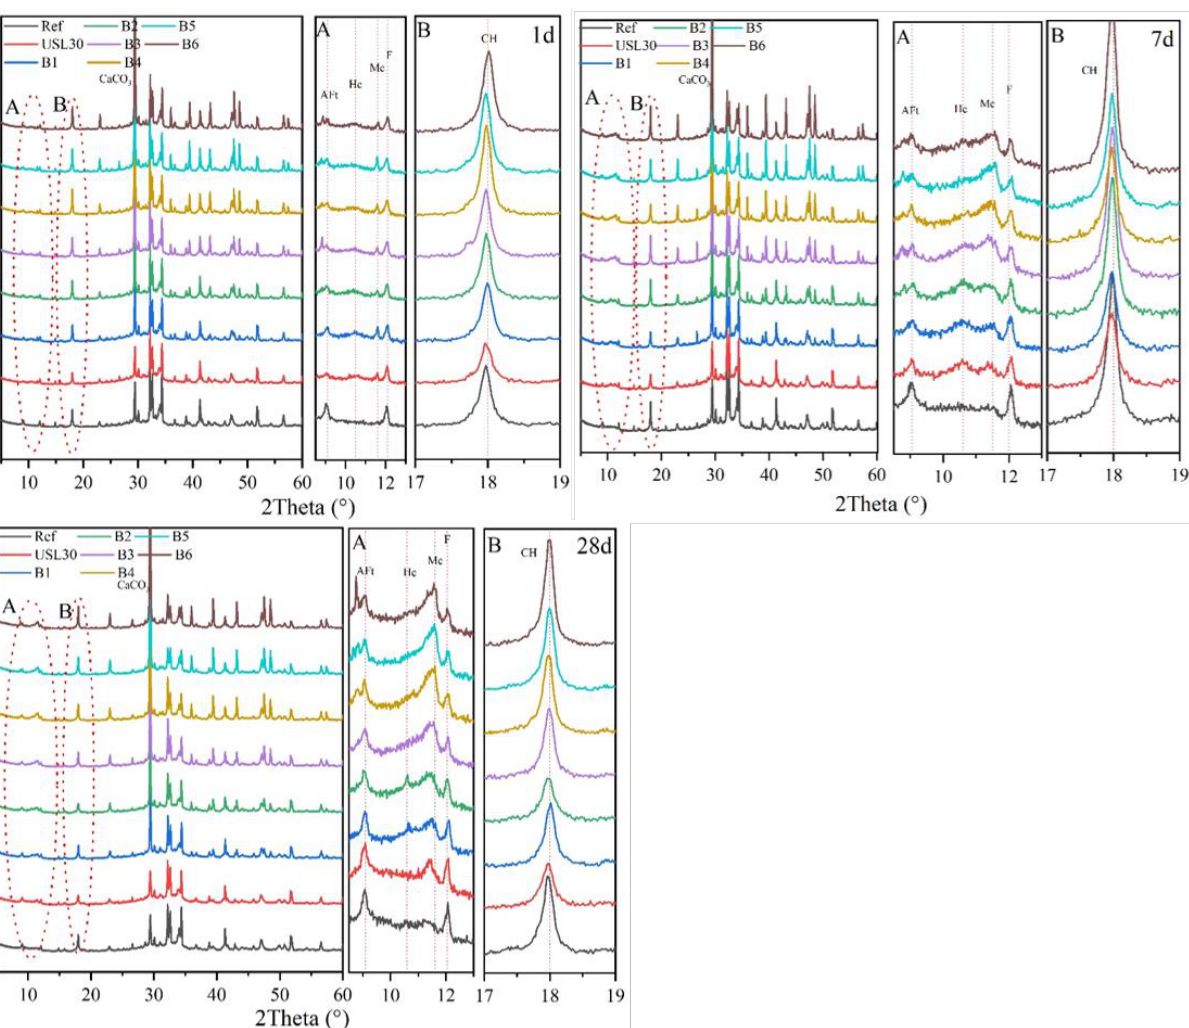
Figure 8. XRD patterns of the blends at 1 d, 3 d, and 28